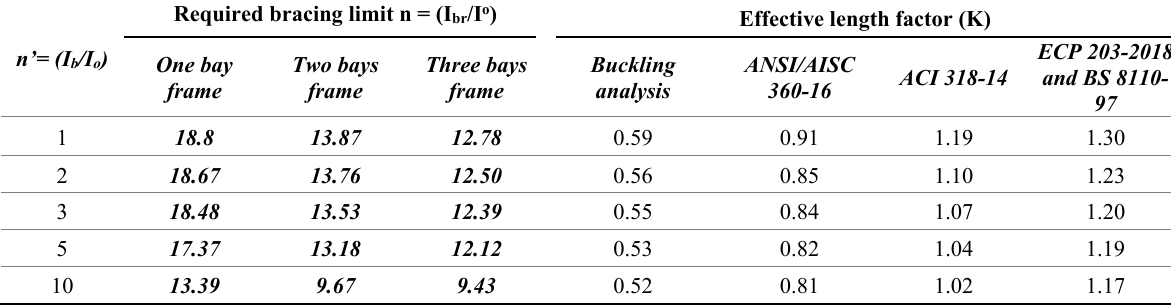
Table 2. Required bracing limit and effective length factors for the two-stories frames.